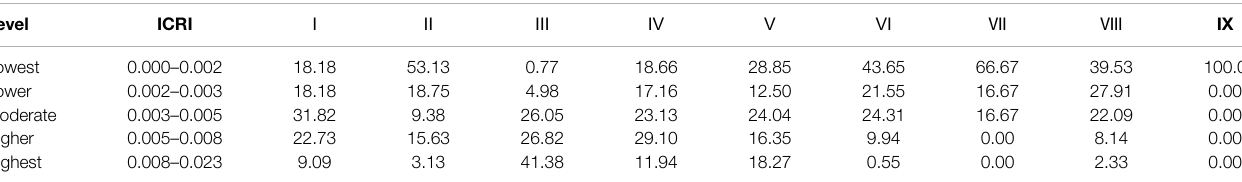
TABLE 4 | Percentage of counties at each level of ICRI to total counties in corresponding main agricultural zones.